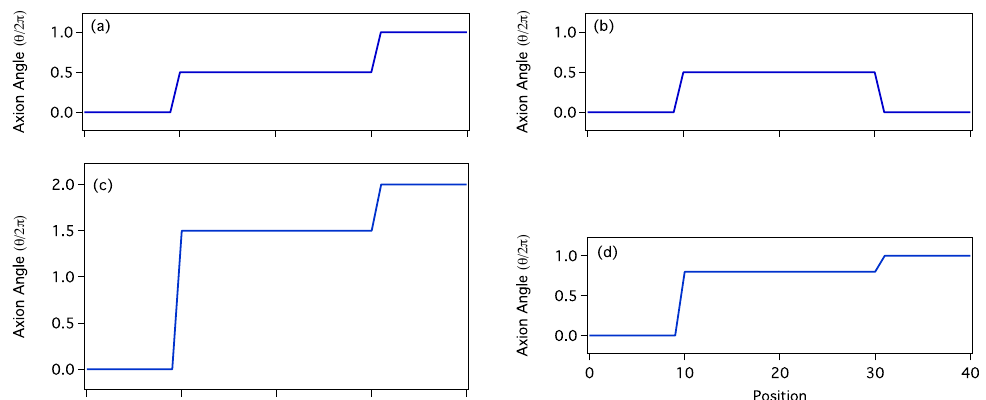
Figure 10: The axion angle θ as a function of space passing through a TI slab for four different scenarios. Jumps in the axion angle are shown as occurring at the sample surface positions. a) A TI slab in magnetic field, showing the minimal jumps of π on e 2 each. b) A TI slab with an each surface that corresponds to two Hall effects of 1 2 h inwardly directed magnetization for each surface c) A TI slab with a quantum Hall e 2 layer on the front surface in addition to the 1 Hall effect. d) An example of a TI slab 2 h for a material that does not have inversion symmetry. The jumps in the axion angle on the front and back surfaces are not quantized, giving surface fractional quantum Hall effects of arbitrary magnitude. However, the net winding of the axion angle is quantized in units of 2 π and hence the total Hall conductance of the full slab is an integer times e 2 / h